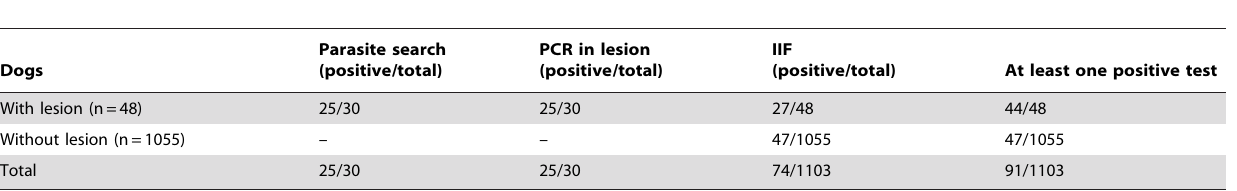
Table 1. Results of laboratory exams used for diagnosis of cutaneous leishmaniasis in canine population in rural locations of the municipality of Arapongas, State of Parana´,